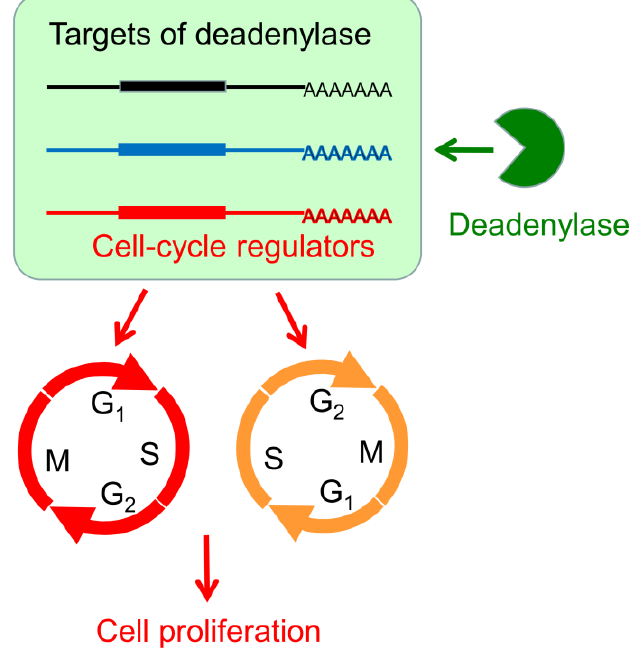
Figure 8. A working model demonstrating the modulation of cell proliferation by the hCaf1a/b and hCcr4a/b deadenylases. A deadenylase targets a subset of transcripts, which includes transcripts encoding cell cycle regulators. Alternations in the deadenylase level may induce G1 or G2 arrest by affecting the levels of cell cycle regulators directly or by modifying the global mRNA metabolism indirectly.